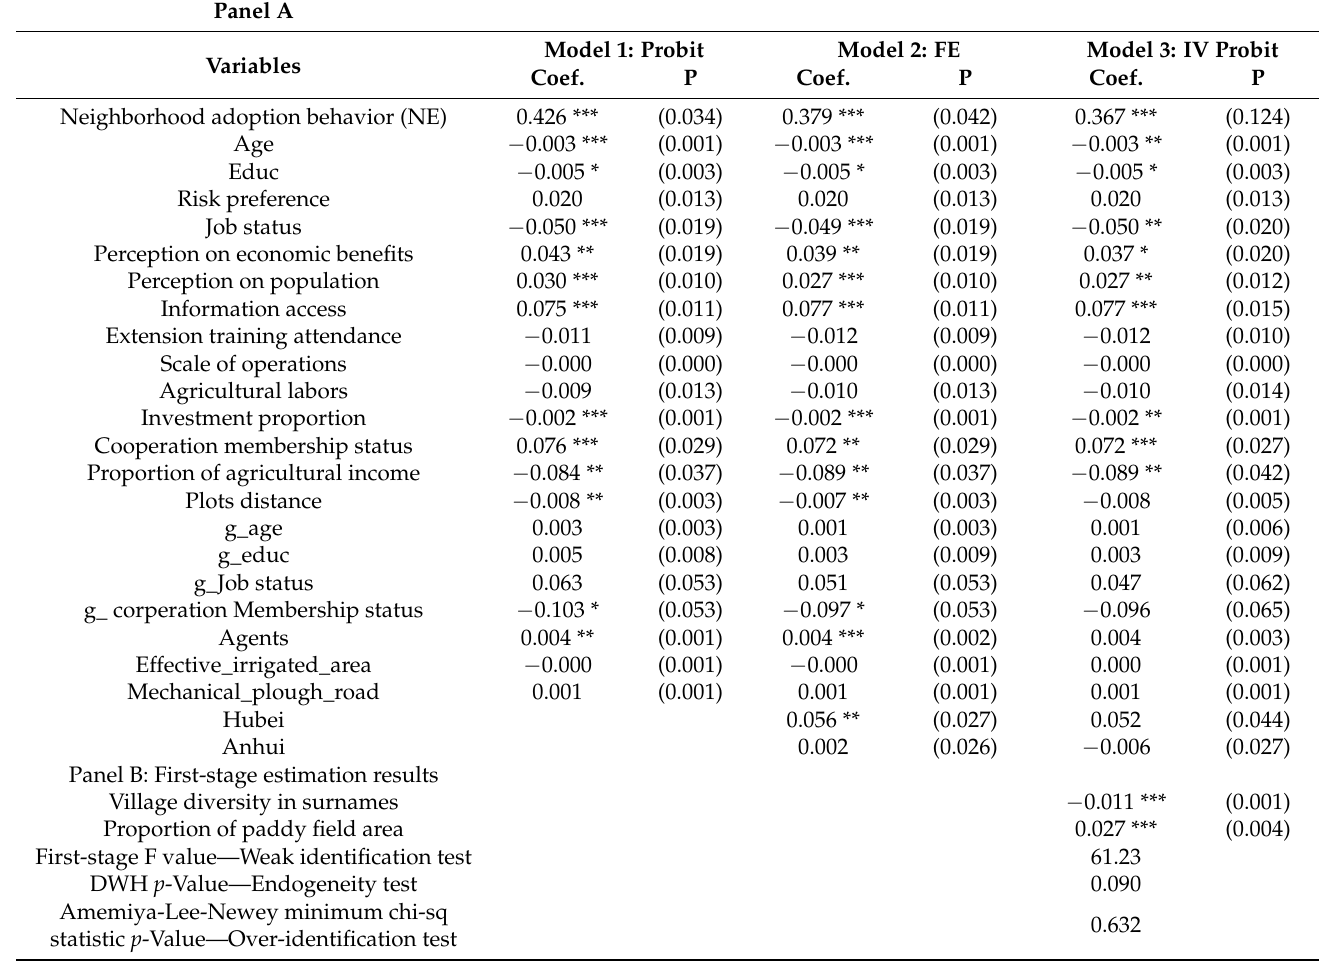
Table 2. Neighborhood effect in farmers’ adoption